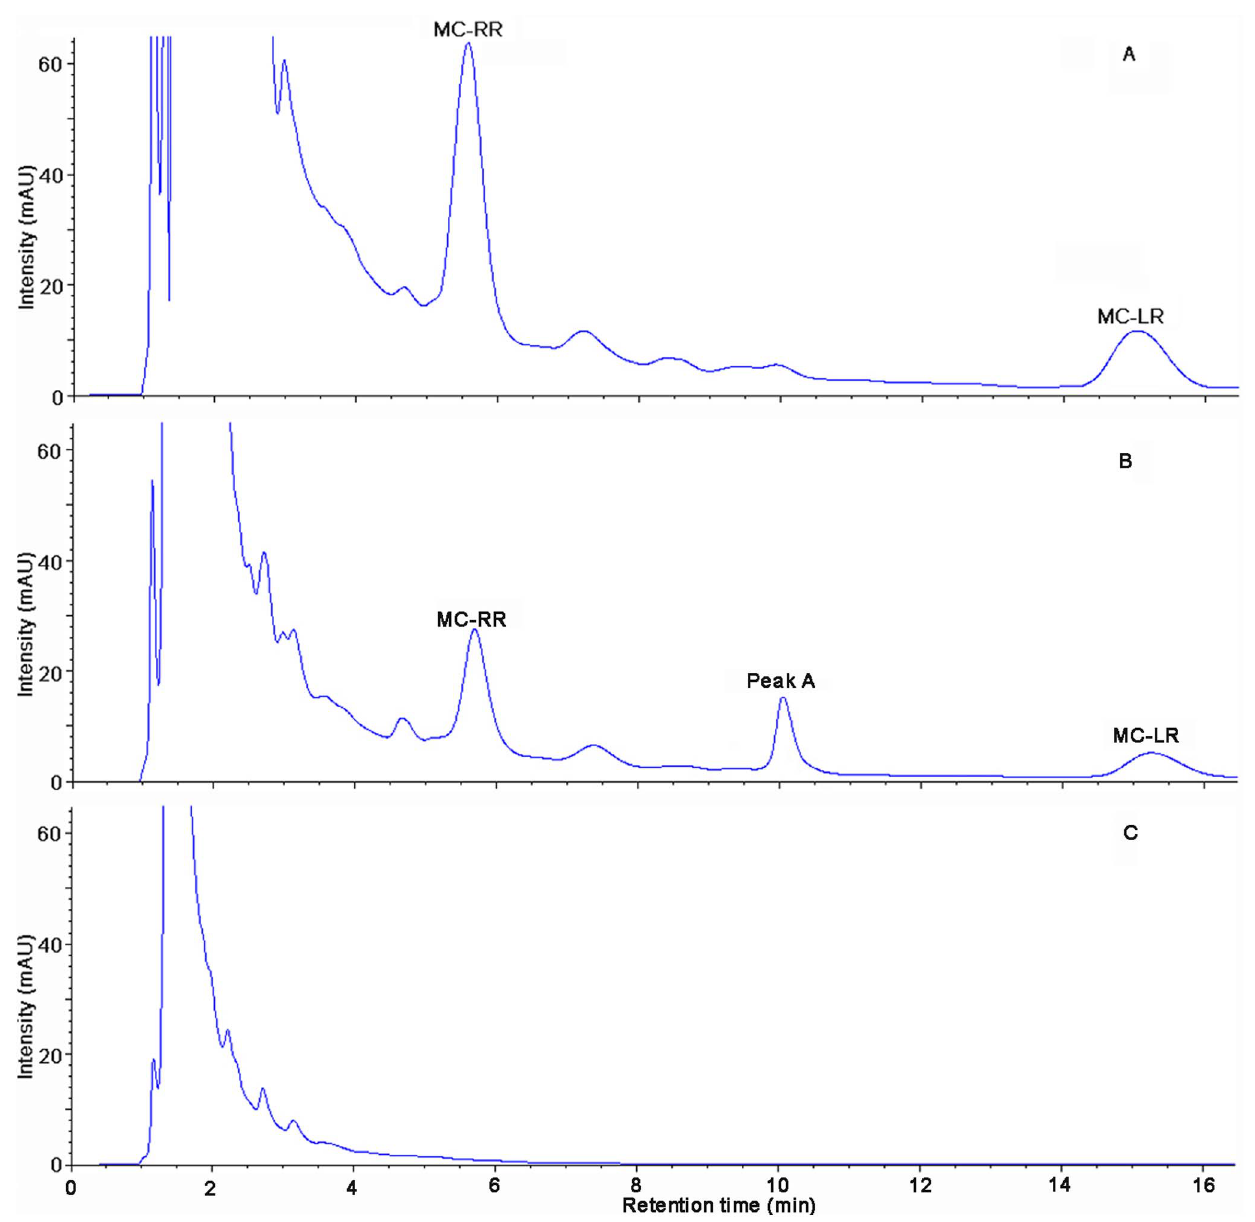
Figure 5. HPLC chromatograms obtained during the biodegradation of MCs. At time zero (A), 6 d (B), 8 d (C). Peaks A showed an intermediate product of